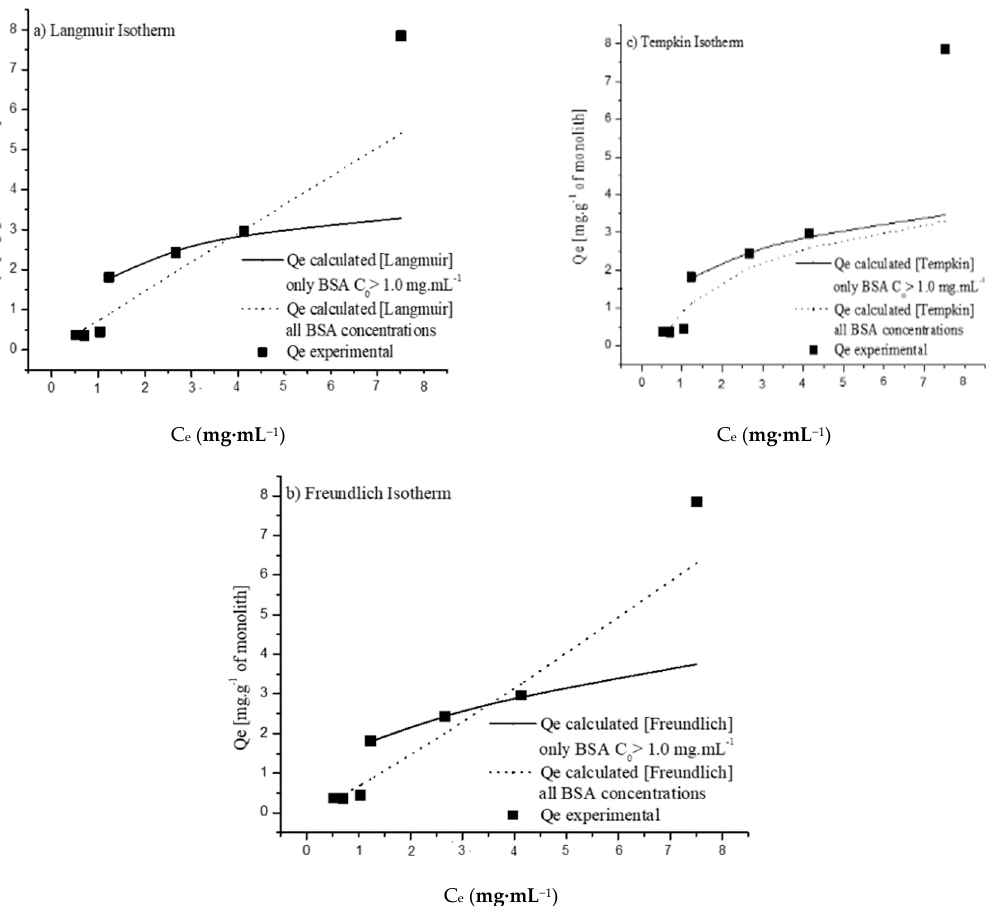
Figure 2. Fitting of BSA adsorption data at the equilibrium (Q e (mg.g − 1 of monolith)) obtained as function of concentration remaining in solution at the adsorption equilibrium (Ce), varying BSA initial concentration (0.5–5 mg/mL) with ( a ) Langmuir, ( b ) Freundlich, and ( c ) Tempkin isotherms. The values of the maximum adsorption amount (Q m ), correlation coefficient (R 2 ), chi-squared ( χ 2 ), and the other parameters for all of the isotherms are shown in Table 2. The Langmuir isotherm [34] assumes that adsorption occurs on a homogeneous surface containing sites with equal energy and that are equally available for adsorption. This is valid for the complete monolayer of adsorption, on which there is no transmigration of the adsorbate on the surface plane. A Q m value of of 3.95 mg·g − 1 was obtained for this